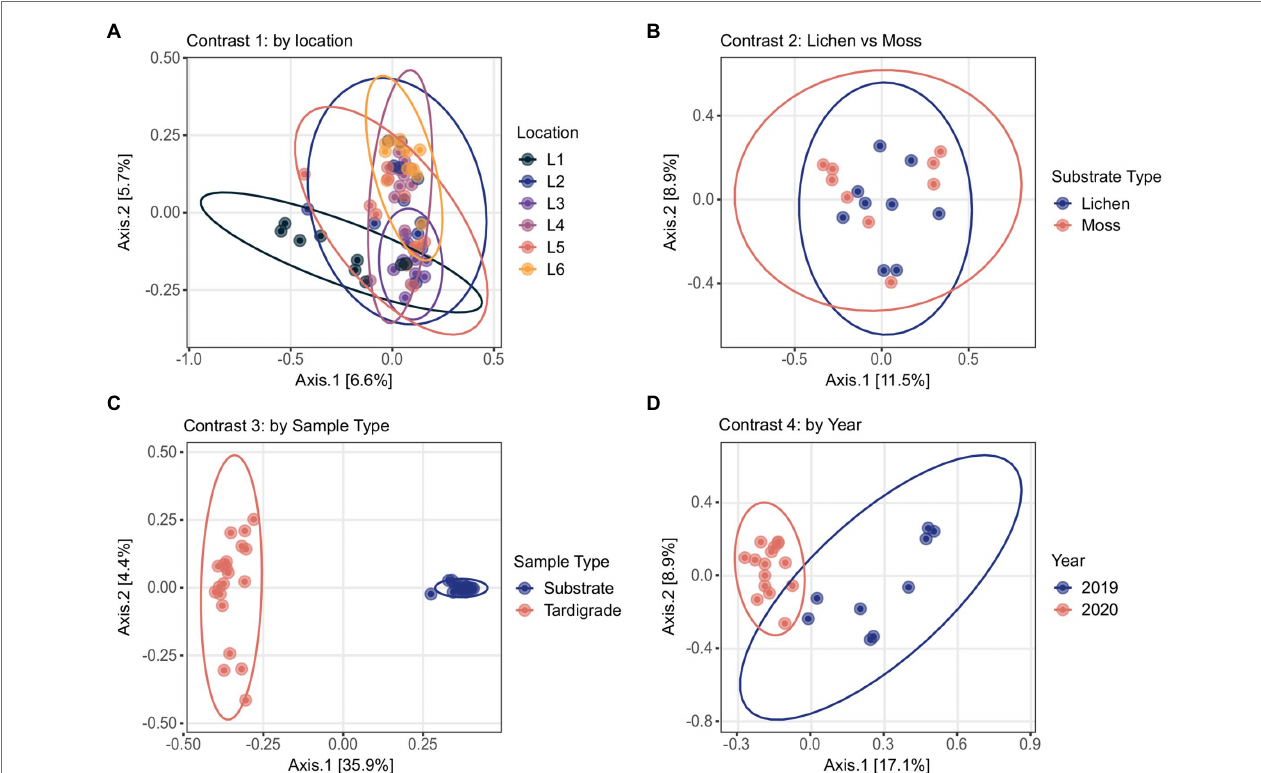
FIGURE 1 | Principal Coordinates Analyses conducted by contrast based on Bray-Curtis distance. Location names (Location 1 through Location 6) are abbreviated as L1 through L6. (A) Tardigrade samples from different locations overlap one another, as do (B) tardigrades isolated from lichen and moss. However, (C) tardigrade and substrate samples are clearly separated, and (D) 2019 and 2020 tardigrade samples are mostly separated.